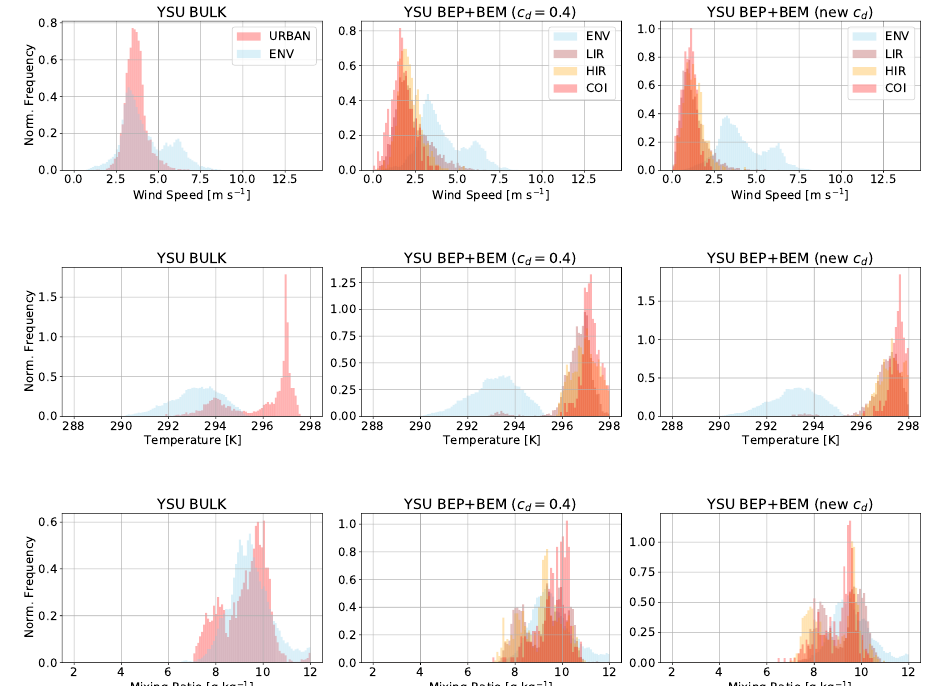
Figure 17. Normalized histograms from the simulations at 12:00 a.m. UTC 22 January (7:00 p.m. LST), evening in Houston prior to the passage of the cold front. Histograms are 50% transparent so that overlapping histograms can be seen. In the left column, URBAN denotes land-use index 13 (Table 3), and ENV denotes the rural environment (all other land-use indices). In the middle and right columns, the urban area is stratified by the LIR, HIR, and COI land-use indices (31, 32, and 33 from Table 3, respectively), and ENV includes all other land uses.